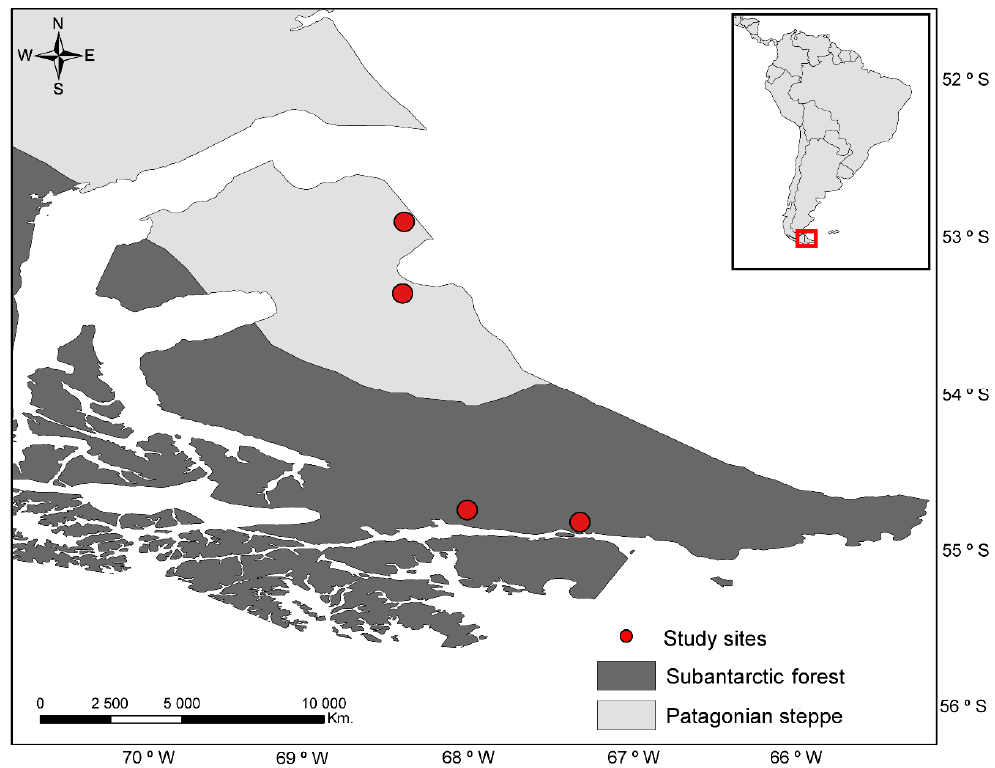
Figure 1. Location of study areas in Tierra del Fuego Island. Red circles indicate study sites.